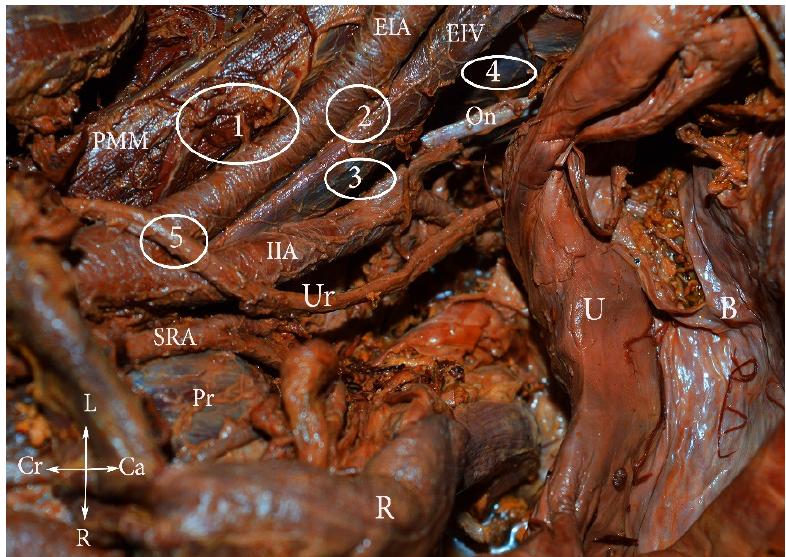
Figure 2. External iliac lymph nodes classification (embalmed cadaver). 1. Lateral—lateral to external iliac artery, 2. middle—medial to the EIA and lateral to the EIV, 3. medial—medial to both external iliac vessels, 4. obturator—around the obturator nerve and vessels, 5. interiliac—at the level of CIA bifurcation, between the EIA and IIA. PMM—psoas major muscle, EIA—external iliac artery, EIV—external iliac vein, IIA—internal iliac artery, Ur—ureter, U—uterus, B—bladder, SRA—superior rectal artery, Pr—promontorium, R—rectum, L—left, r—right, Cr—cranial, Ca—caudal.